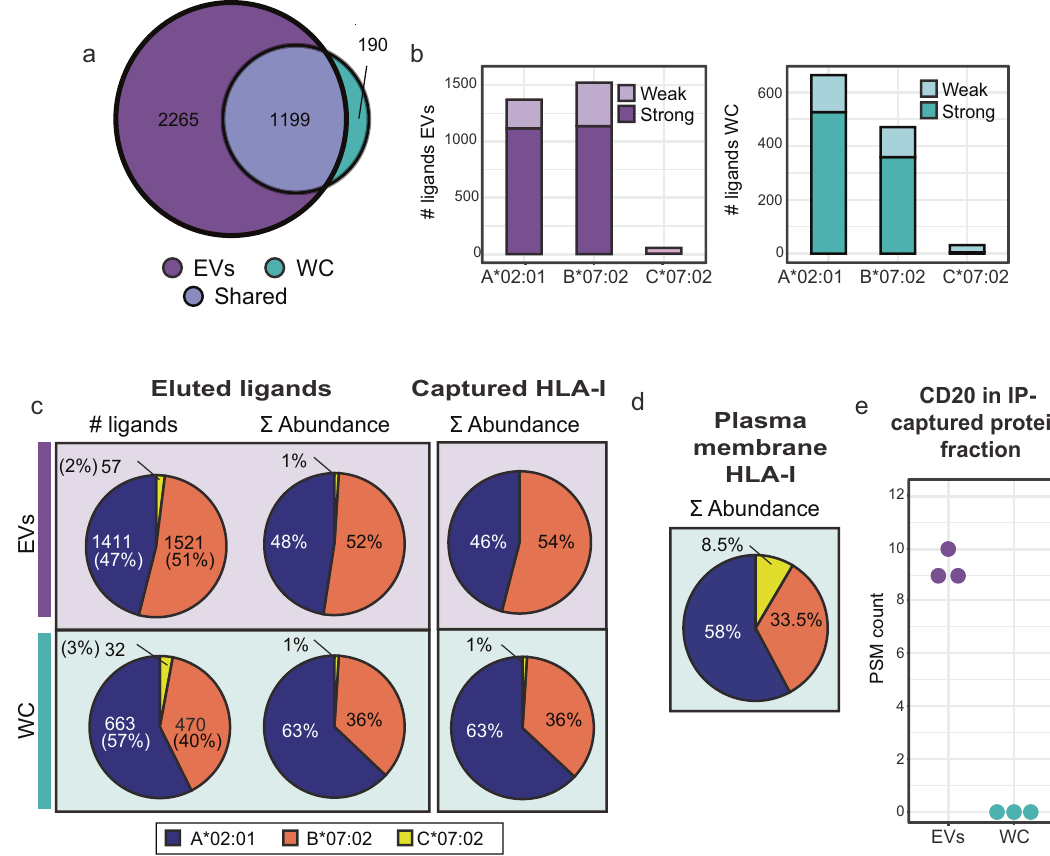
Fig. 3 Unique characteristics of the EV HLA-I peptide ligandome. a HLA-I peptide species overlap. The JY whole-cell HLA-I peptide ligandome is almost completely sampled in EVs. b Predicted peptide binding af fi nity to JY HLA type. More HLA-B binding peptides were detected from EVs. Distribution of strong ( ≤ 50 nM af fi nity) and weak ( ≤ 500 nM af fi nity) peptide binders respectively. Bar plots represent the total pool of eluted ligands detected in three technical replicates from either WC (green) or EVs (purple). c Proportion of HLA-A (blue), HLA-B (orange), HLA-C (yellow) binders. HLA-A binders were over-represented in the JY whole-cell HLA-I peptide ligandome in both peptide species count and summed abundance, which was corroborated by the relative abundance of captured HLA-A and HLA-B proteins. A more balanced proportion of HLA-A to HLA-B was observed in EVs. d HLA-I complexes puri fi ed from the plasma membrane show a similar abundance distribution to what observed on whole-cells. e Spectral count of CD20 co- immunoprecipitated with HLA-I. CD20 (MS4A1) was con fi dently detected exclusively in the EV HLA-I